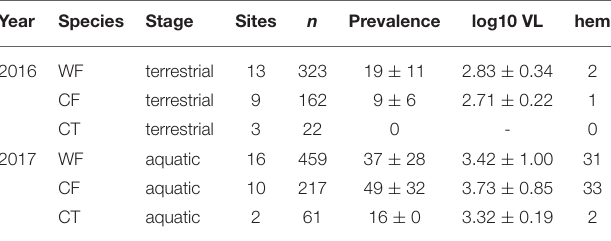
TABLE 3 | Amphibian species sampled in 2016 and 2017, with respective life-stage, number of sampling sites, sampled individuals, ranavirus prevalence (% + / − SD), and viral loads.